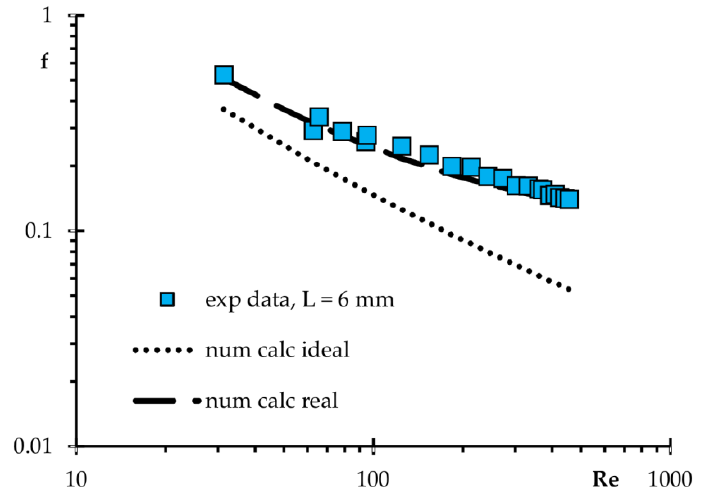
Figure 3. Comparison of numerical and experimental results for tested structure.